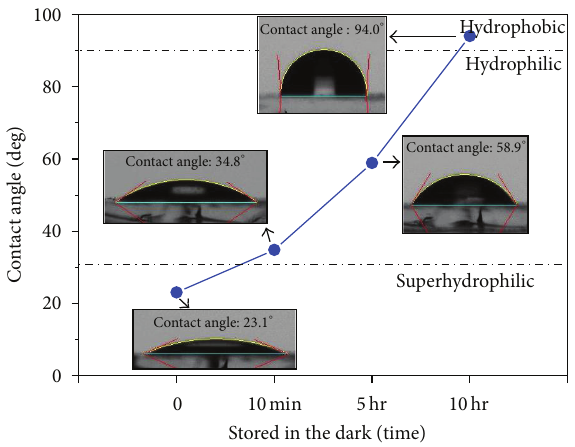
Figure 8: Stored in dark time dependence of water CAs for the ZnOthinfilmsdepositedat100WunderUVphotoirradiation.Inset showed the corresponding water CA images accompanied with the measured values of the ZnO (0002) columnar